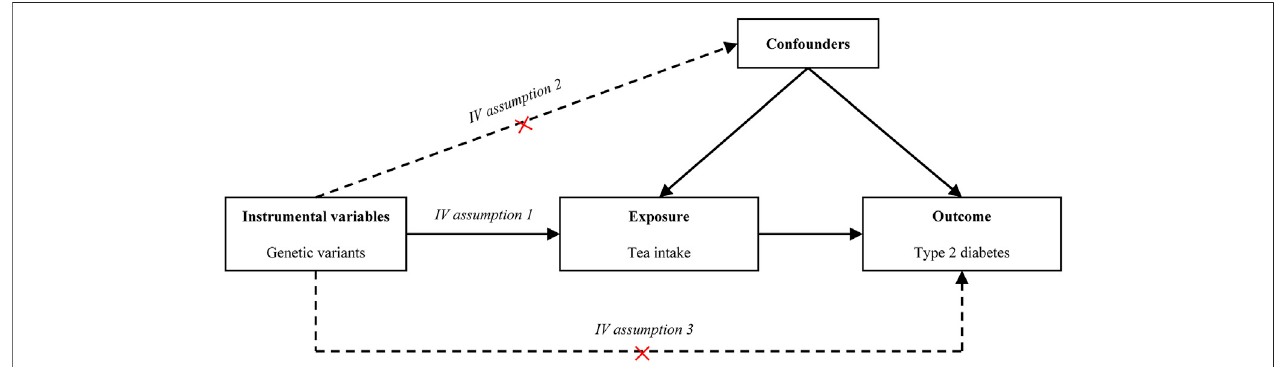
FIGURE 1 | Causal diagram. The causal diagram for Mendelian randomization (MR) involves instrumental variables (IVs) and requires three assumptions: (1) Relevance. The IVs associate robustly with the exposure. (2) Independence. The IVs are not associated with observed or unobserved confounding factors for the exposure and outcome. (3) Exclusion restriction. The IVs only affect the outcome through exposure. Dotted lines represent a possible condition that the assumptions may be violated. Abbreviation: IV, instrumental